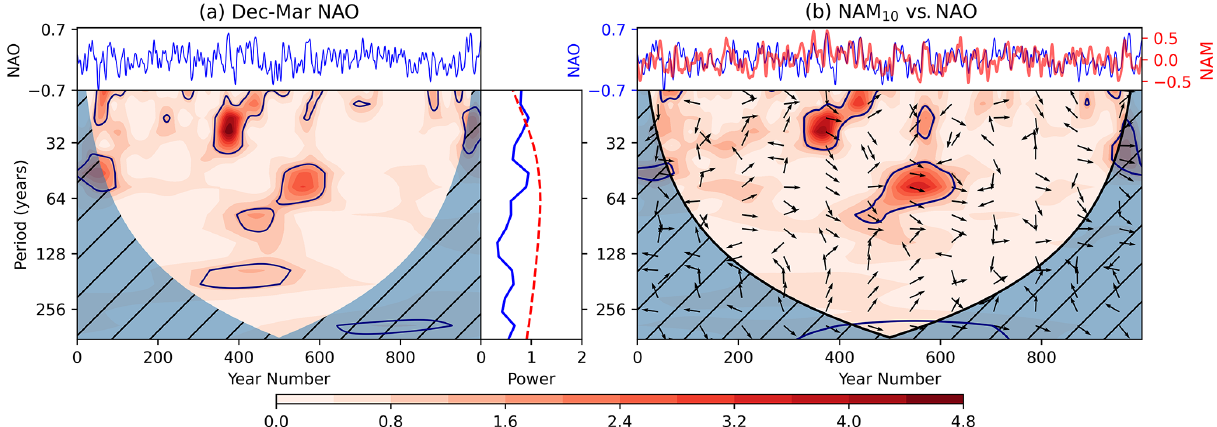
Figure 9. Same as Fig. 8 but for the Dec–Mar NAO index. Panel (a) shows the wavelet power spectrum of the NAO, and panel (b) shows the cross-power spectrum between the NAO and the NAM 10